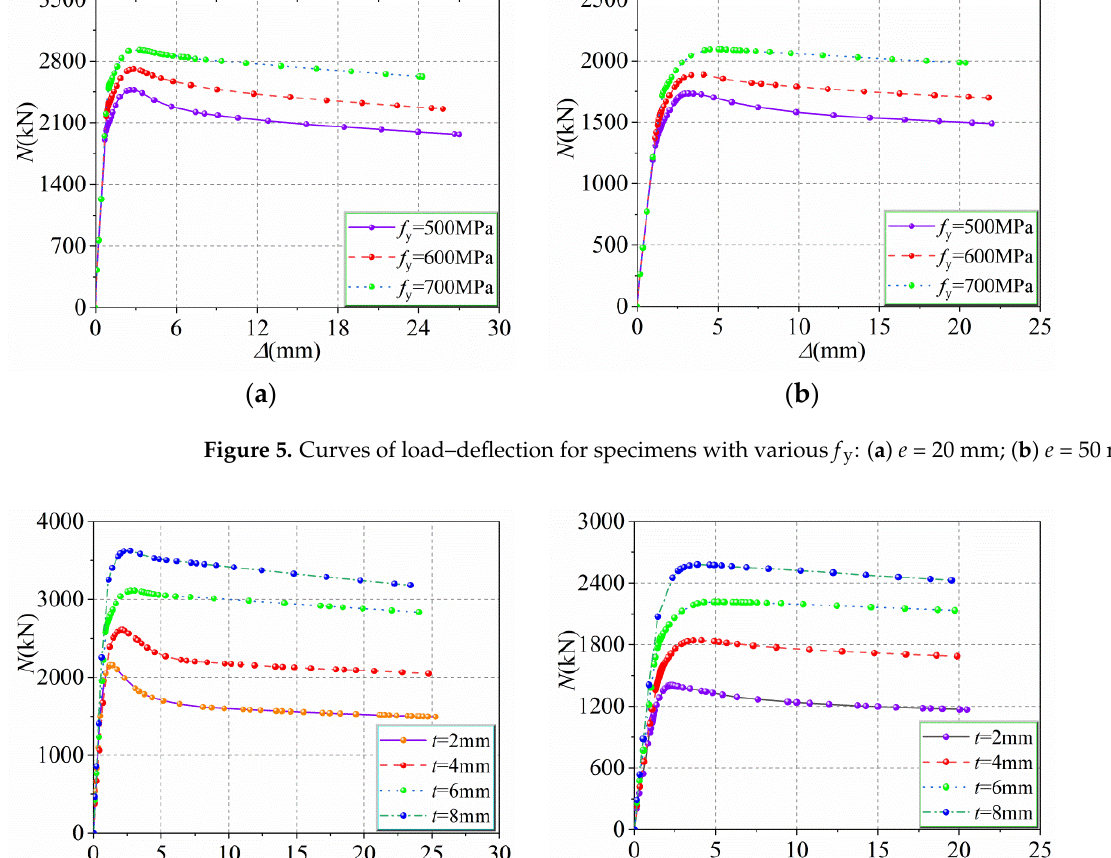
Figure 7. Curves of load – deflection for specimens with various f y1 : ( a ) e = 20 mm; ( b ) e = 50 mm.